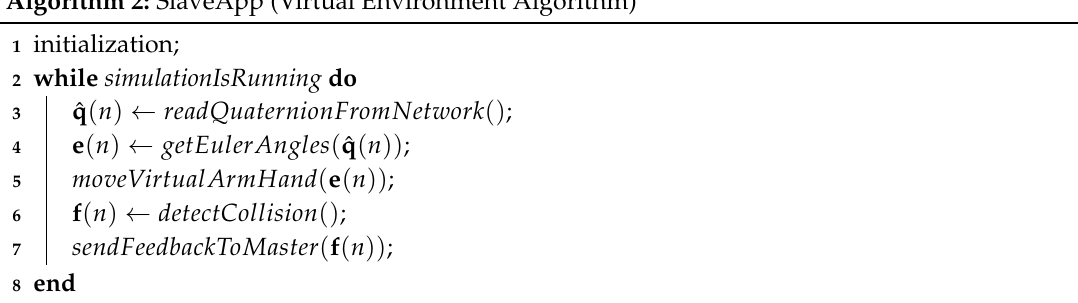
Algorithm 2: SlaveApp (Virtual Environment